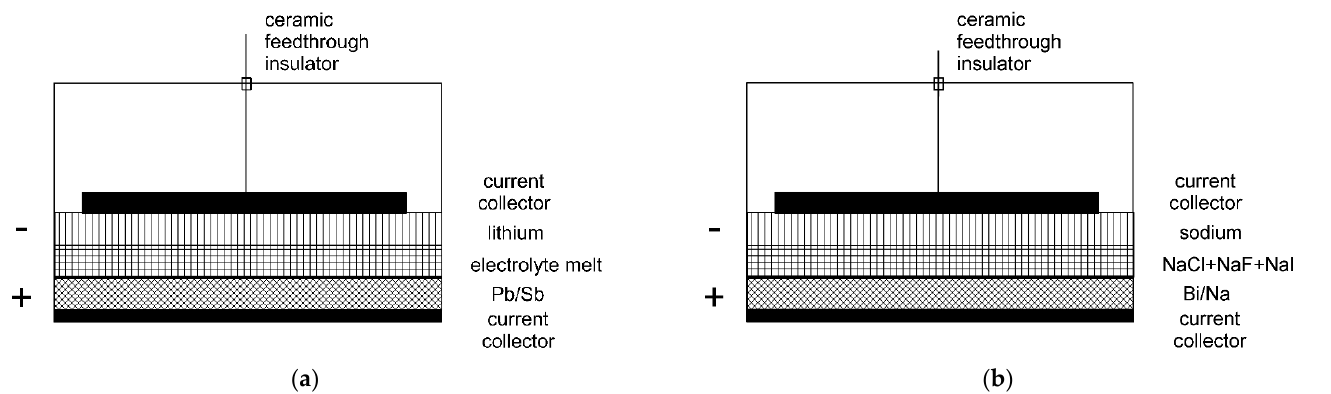
Figure 2. ( a ) Schematic cross section of an all-molten metal accumulator. ( b ) Schematic cross section of an Na|NaCl–NaF–NaI|BiNa cell. of an Na|NaCl–NaF–NaI|BiNa